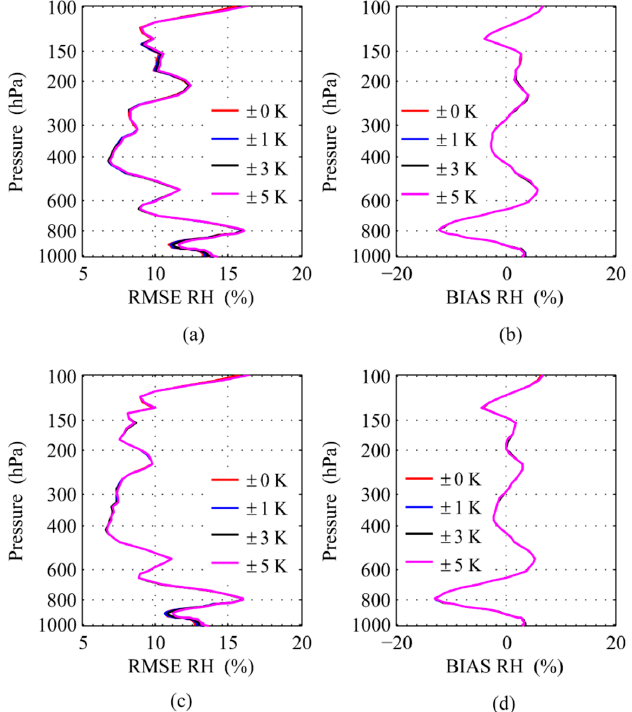
Figure 10. The humidity retrieval results of FY-4A and FY-4B with different temperature perturba- tions: ( a ) RMSE of FY-4A; ( b ) BIAS of FY-4A; ( c ) RMSE of FY-4B; ( d ) BIAS of FY-4B. ( a ) RMSE of FY-4A; ( b ) BIAS of FY-4A; ( c ) RMSE of FY-4B; ( d ) BIAS of